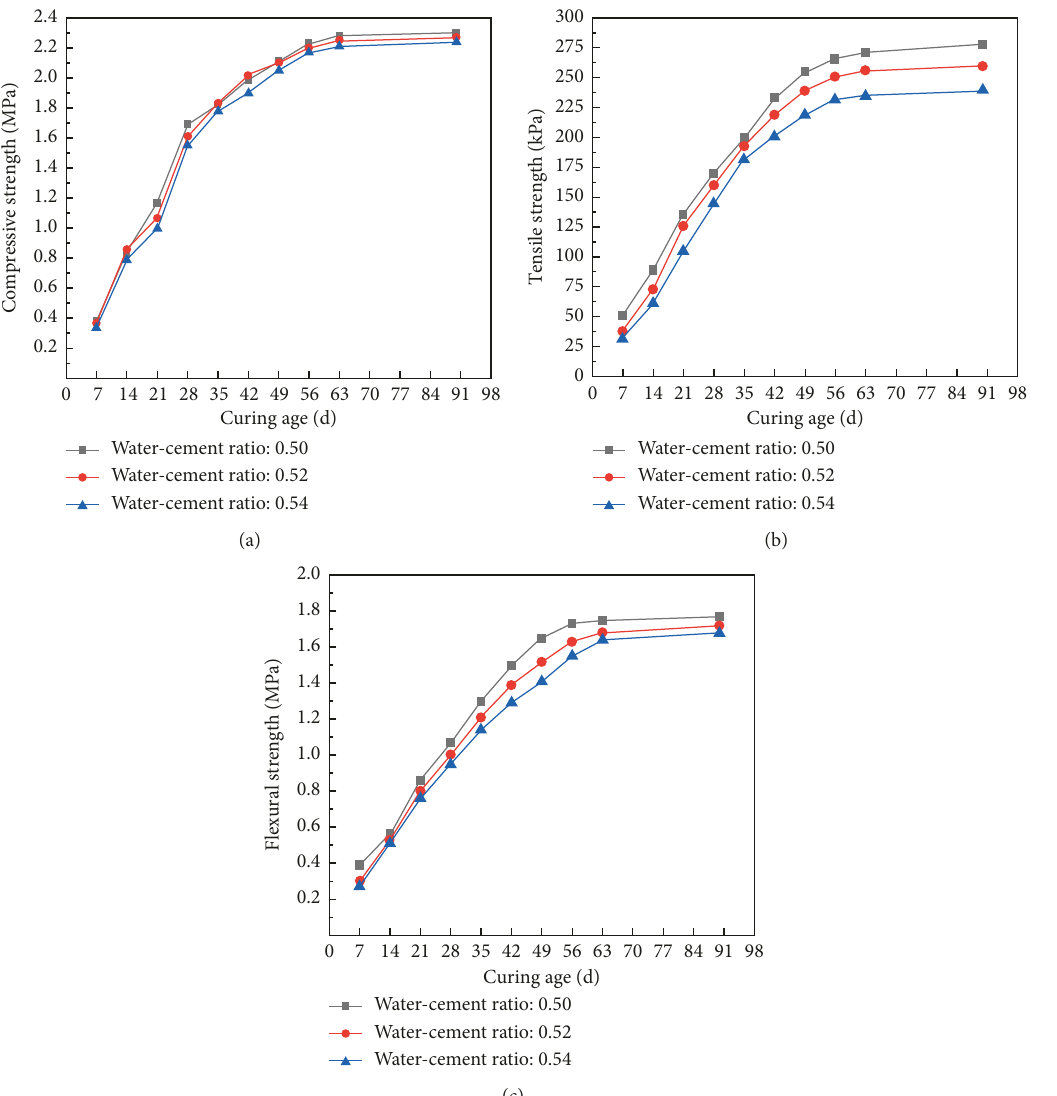
Figure 2: Variations in the (a) compressive, (b) tensile, and (c) flexural strengths against the curing